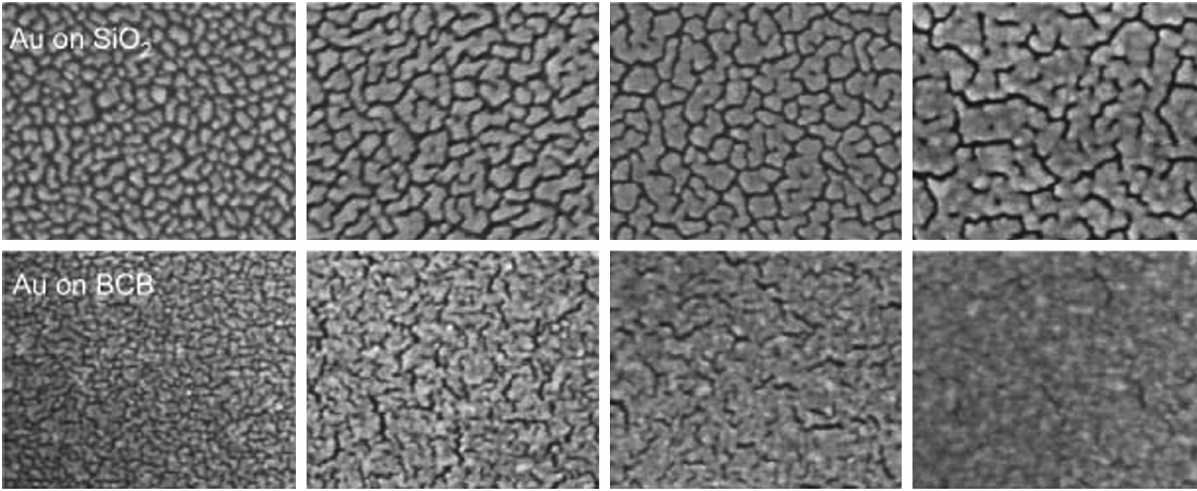
Figure 2: Ultrathin (3, 4.2, 5.4 and 7.2 nm respectively) Au layers on pure silica (upper row) and on BCB polymer (lower row). Reproduced with permission from